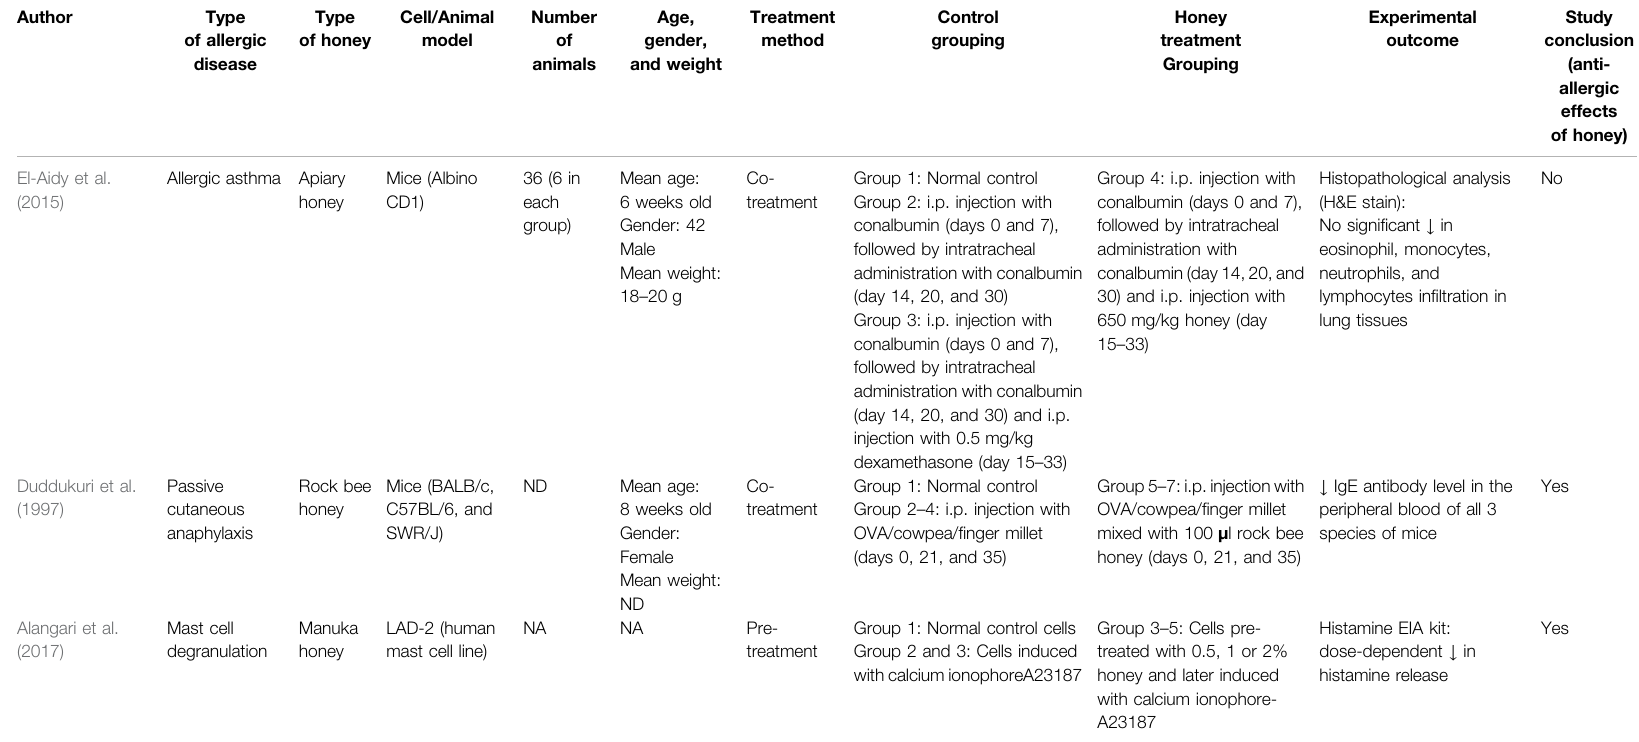
Co- Group 1: Normal control treatment Group 2: i.p. injection with conalbumin (days 0 and 7), followed by intratracheal administration with conalbumin Mean weight: (day 14, 20, and 30) 18 – 20 g Group 3: i.p. injection with conalbumin (days 0 and 7), followed by intratracheal administration with conalbumin (day 14, 20, and 30) and i.p. injection with 0.5 mg/kg dexamethasone (day 15 – 33) Co- Group 1: Normal control treatment Group 2 – 4: i.p. injection with OVA/cowpea/ fi nger millet Gender: (days 0, 21, and 35) Female Mean weight: ND NA Pre- Group 1: Normal control cells treatment Group 2 and 3: Cells induced with calcium ionophoreA23187